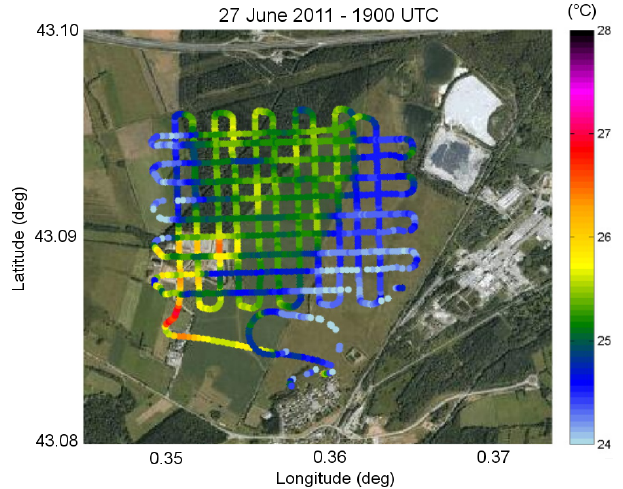
Figure 5. Surface temperature observed by the RPAS SUMO dur- ing an exploration survey 60m above ground at site 2 on 27 June 2011 (IOP 7). At that time and that day, the forest and the maize had similar temperatures, about 1 ◦ C warmer than the moor. The hot spot on the bottom left is a bare ground and concrete surface of a waste disposal area (Google-bilder © 2011 COWI A/S, DDO, DigitalGlobe, GeoEye, Scankort ©